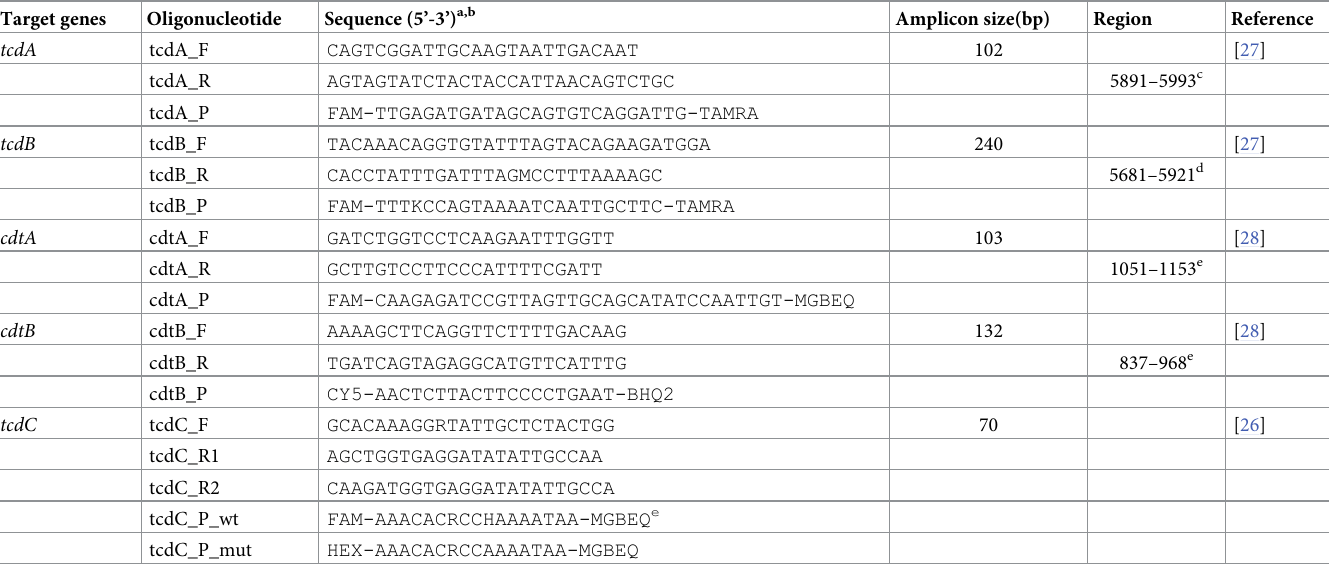
Table 1. Primers and probes used for real-time